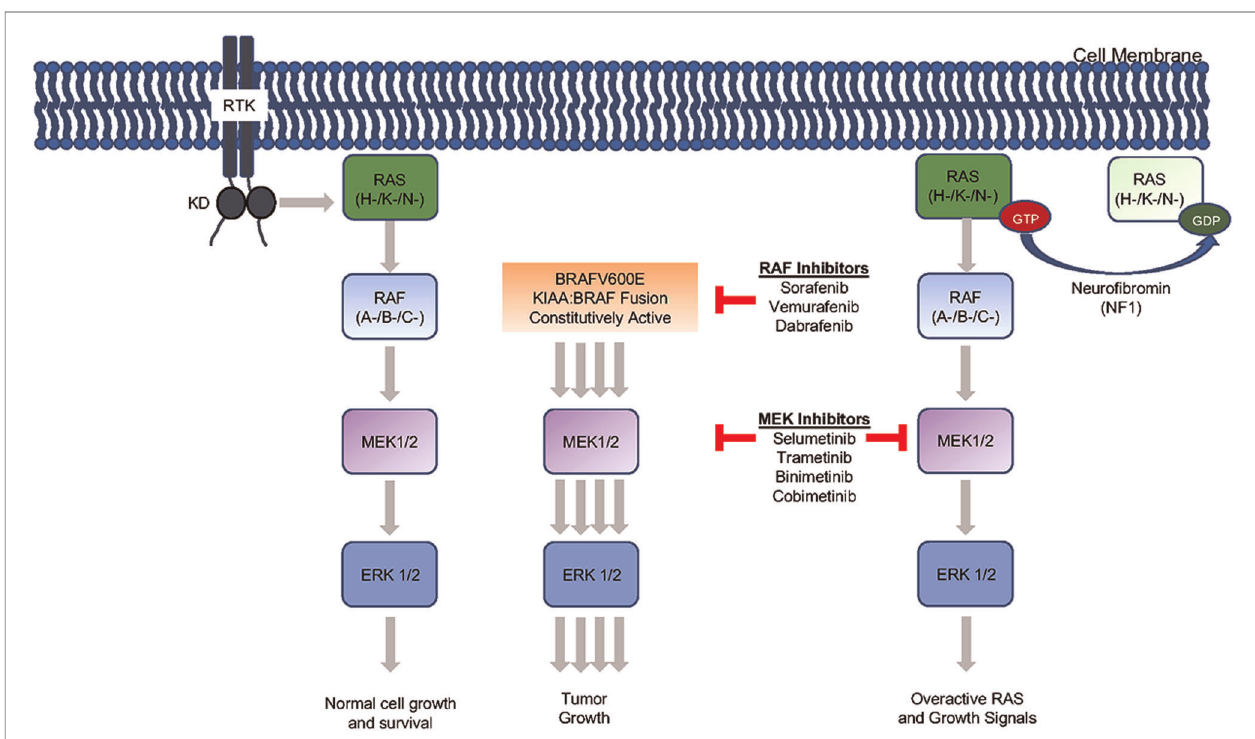
FIGURE 1 | Mitogen-activated protein kinase (MAP kinase) pathway inhibition. The MAP kinase pathway can be inhibited at multiple sites with currently clinically available drugs. Of note, sorafenib (RAF inhibitor) was studies in the low-grade glioma population but found to result in unexpected progression in some patients (29). The additional drugs are use as monotherapy and in combination to treat low-grade